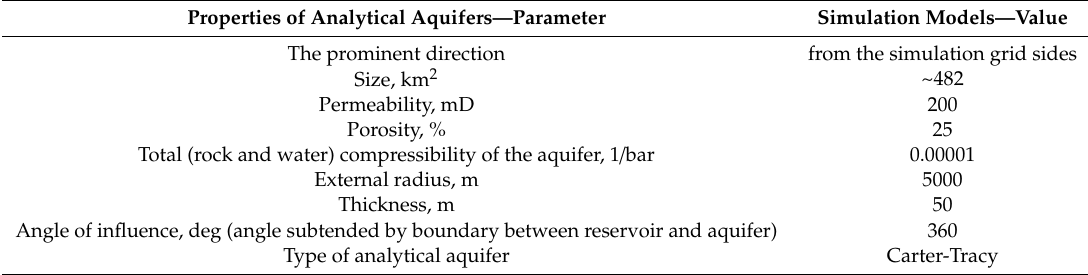
Table 3. Characteristics of the analytical aquifers in the simulation models.